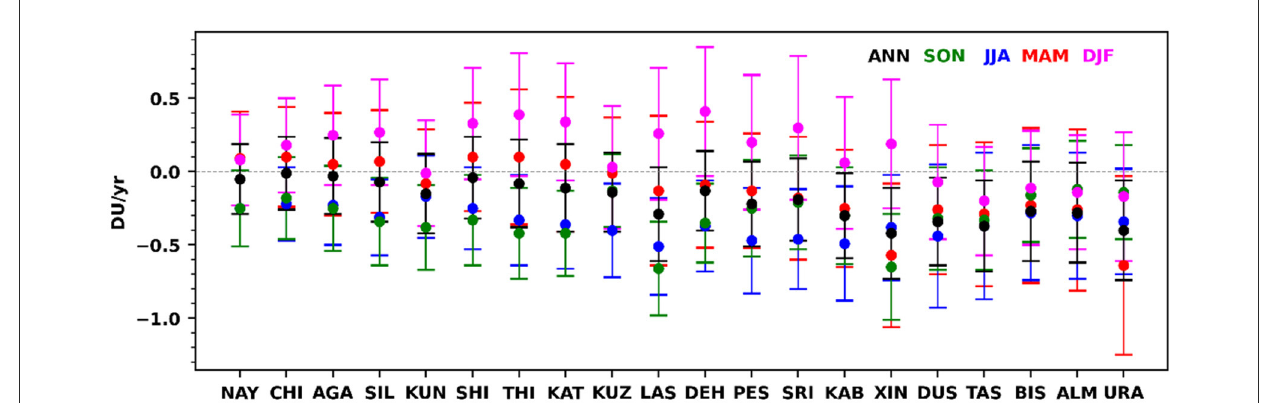
FIGURE4 Annual and seasonal trends in TCO at different cities in TP for the period 2005–2020. The cities are arranged in ascending order in latitude and the details about city names and other are given in Supplementary Table S1. The seasons are defined as spring: March–April–May (MAM), summer: June–July–August (JJA), autumn: September–October–November (SON), and winter: December–January–February (DJF). The annually averaged data are represented by the black line (ANN).